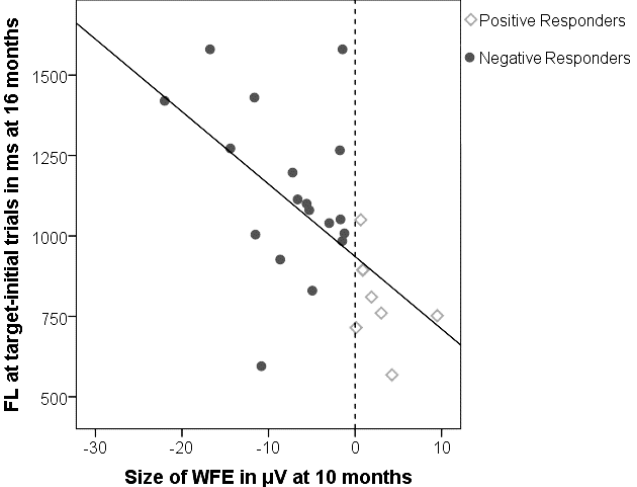
Figure 1. The word familiarity effect on the x-axis, and duration of first looks (FL) for target-initial trials on the y-axis: Infants with a larger negative word familiarity effect at 10 months continue to fixate targets longer at 16 months. The vertical dashed line reflects the subgroups based on polarity of word familiarity effect: Negative Responders fixate longer than Positive